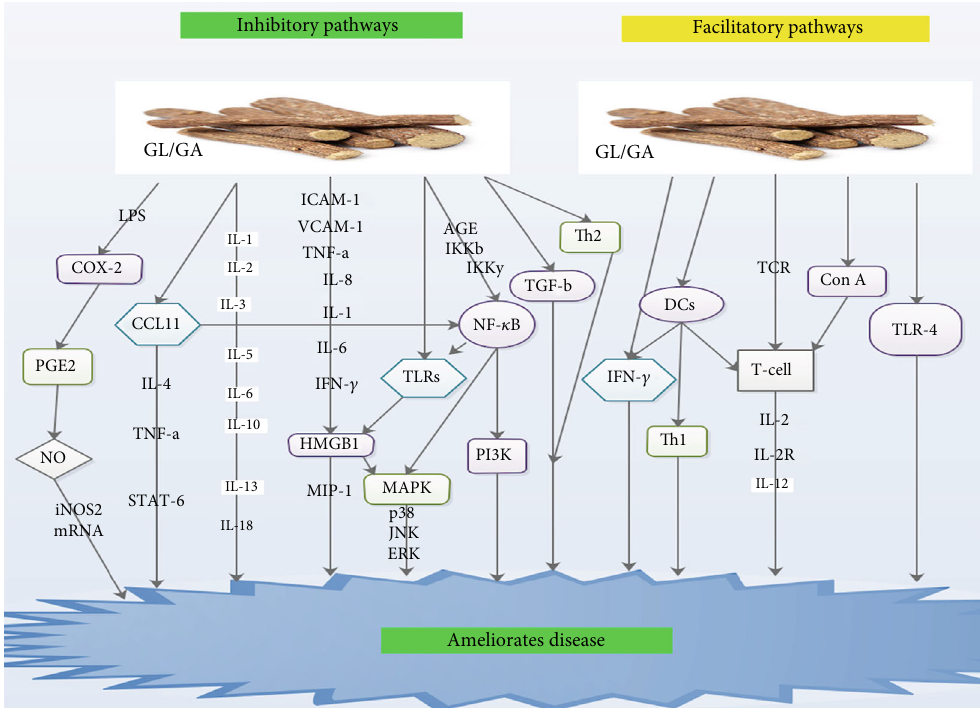
Figure 2: Shows the inhibitory and facilitatory pathways via which GL and GA ameliorate